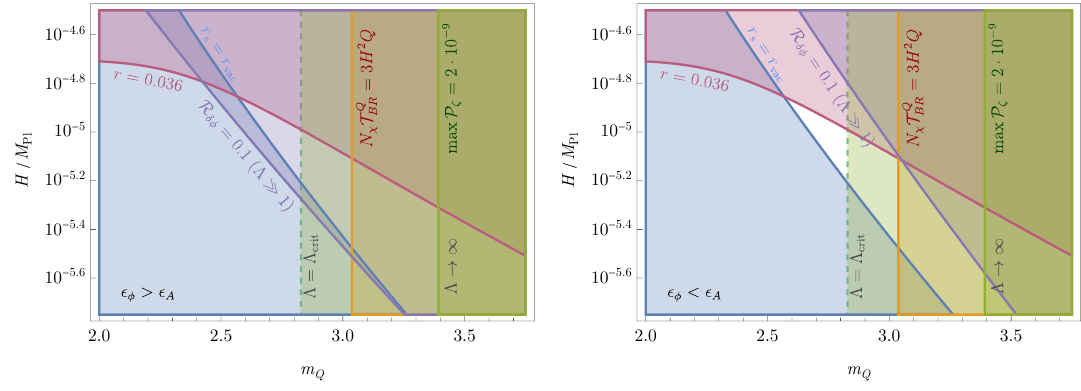
√ Figure 2 . Allowed parameter space of S-CNI in the plane of m Q − H/M Pl . 2 < m Q is satisfied and g = 0 . 01 is fixed everywhere on both panels. The panels show all constraints discussed in this section in classic (left) and mixed (right) S-CNI scenarios: the green shaded region with solid border breaks (CON. 3 ∗ ), the dark yellow region is contaminated by (CON.5), the green shaded region √ with dashed border violates (CON.3) for Λ ∼ 2 , the dark pink region breaks the observational bound r < 0 . 036 (CON.1), the chiral signature in the blue region is too weak (see (CON.2)), and the purple region is contaminated with too large a non-linear contribution to the scalar power spectrum, (CON.6). At small Λ this constraint becomes irrelevant. (Left Panel) For large Λ 2 (cid:29) 1 values, the R δφ > 0 . 1 constraint kills the available parameter space for enhanced chiral signatures of the classic S-CNI branch. (Right Panel) The mixed S-CNI branch satisfies all constraints for 6 . 2 · 10 − 6 . H/M Pl . 1 . 0 · 10 − 5